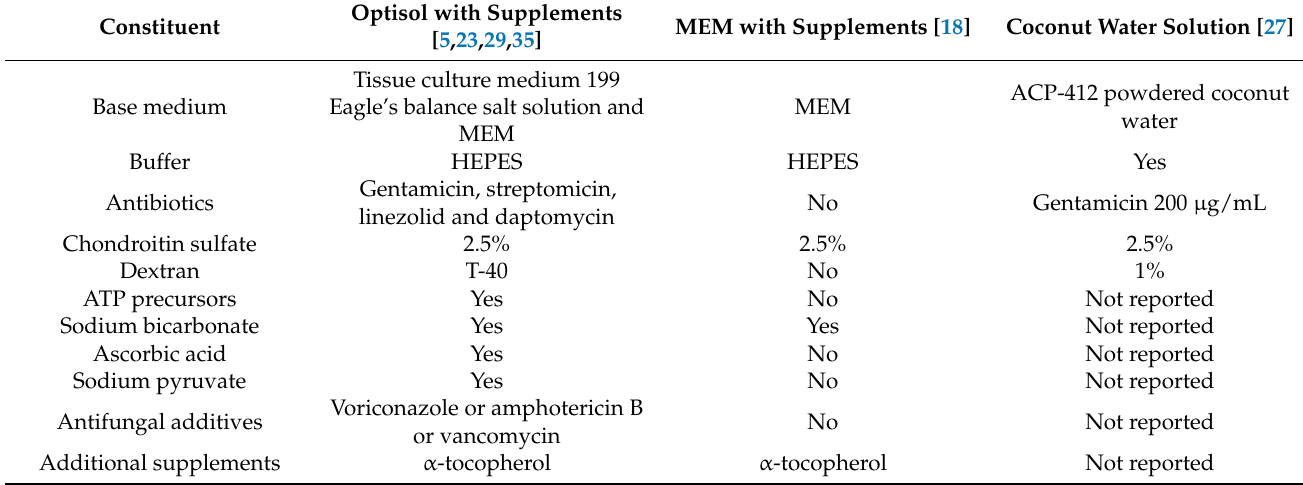
Table 6. List of other modified media and alternative solution